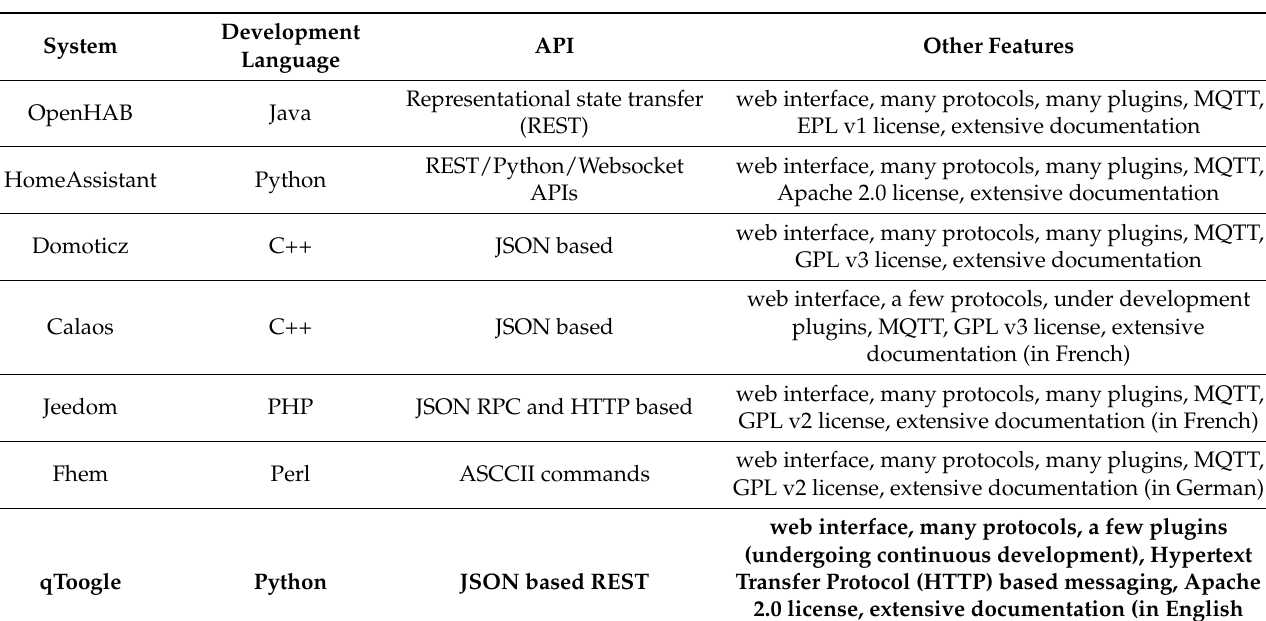
Table 2. Comparison of the most relevant open-source home automation